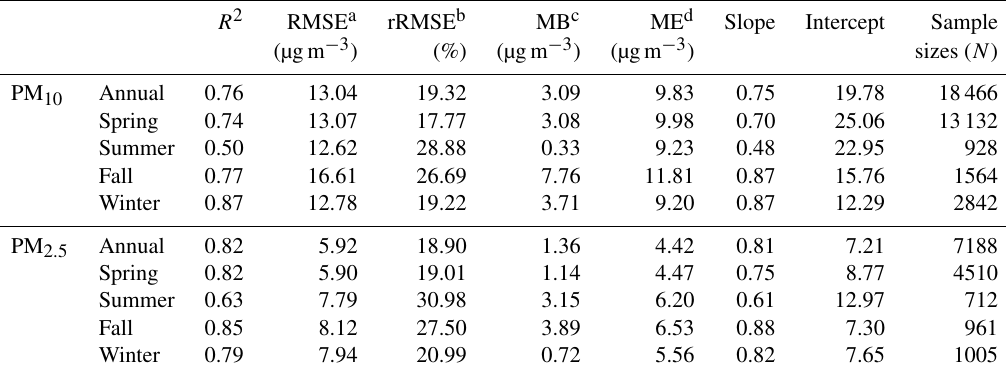
Table 5. Seasonal variation in model performance for estimating particulate matter (PM) concentrations. Spring, summer, fall, and winter correspond to March to May, June to August, September to November, and December to February, respectively.